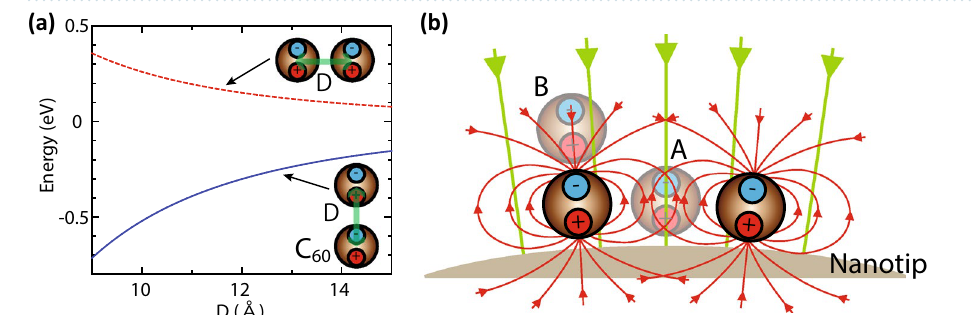
Figure 5. Characteristics of dipole interactions and fields. ( a ) Variations of dipole–dipole interaction energy under an electric field of 4 V/nm with changing D for horizontally- and vertically-aligned dimers, where D is the distance between two molecules. ( b ) Schematic diagram of the lines of the field forces of the induced dipole fields (red lines) and the DC electric fields around a tip (green